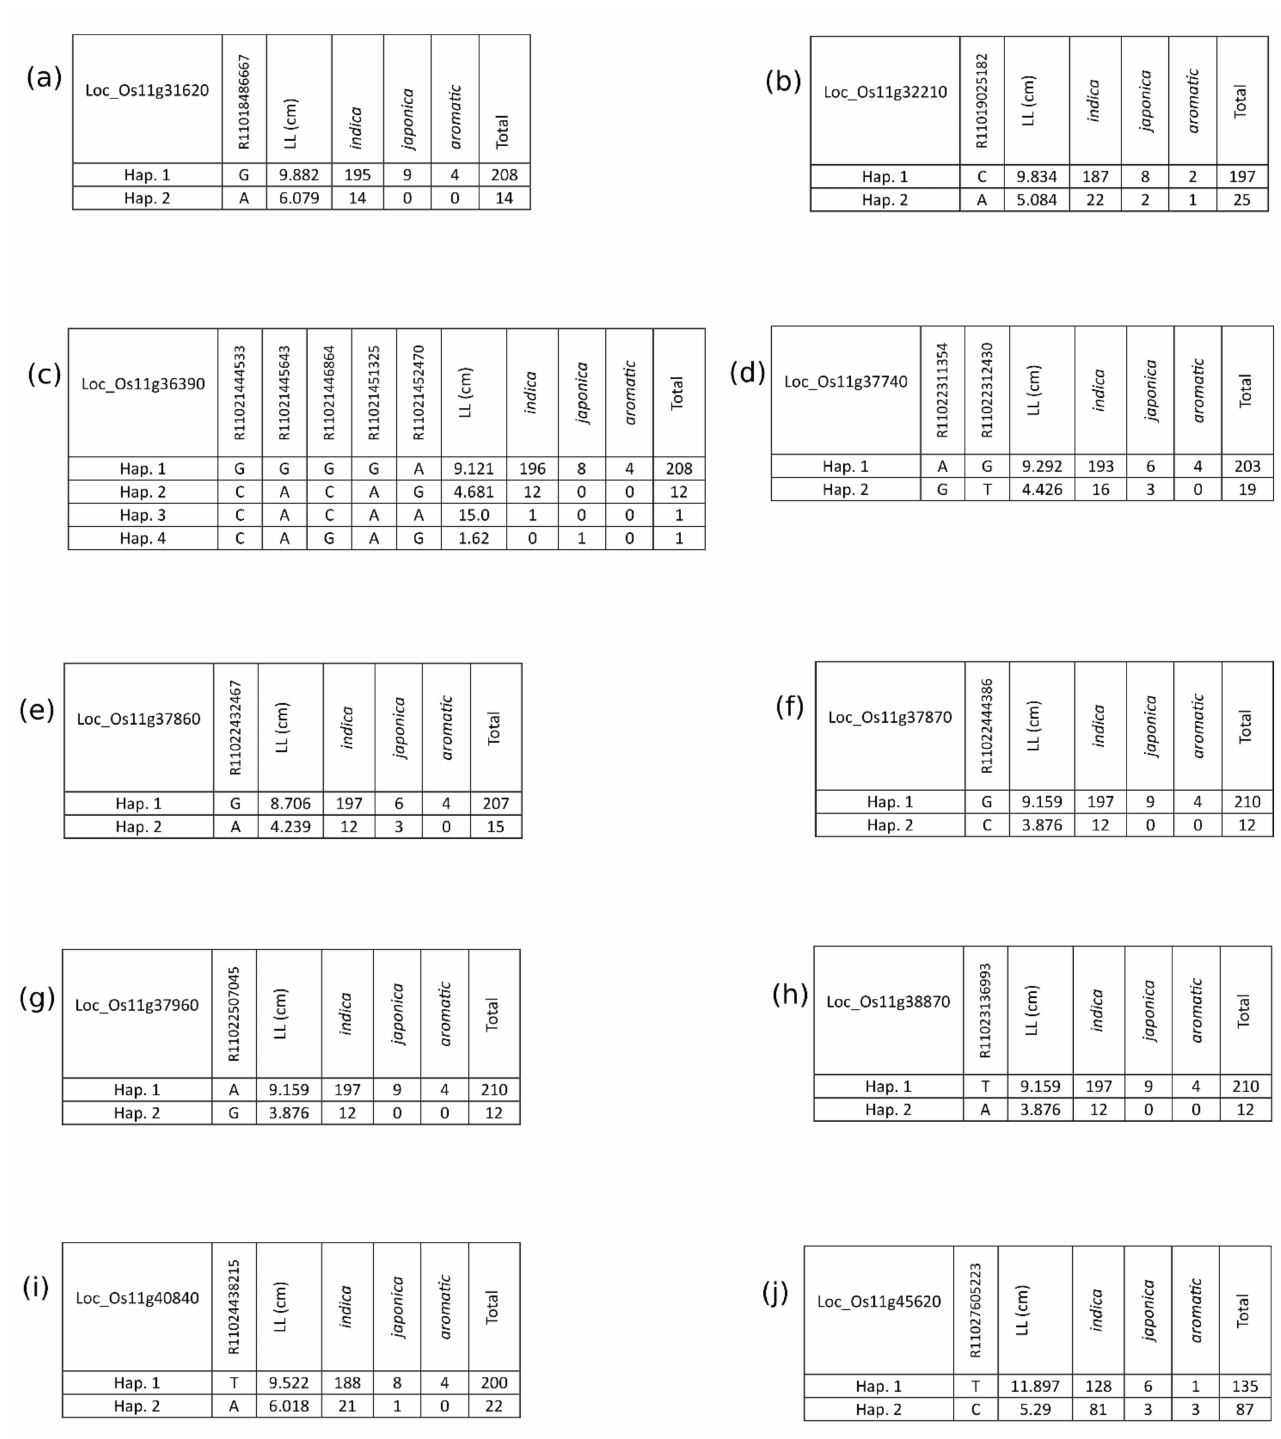
Figure 7. Tabular representation of alternative haplotypes determined by occurrence of significantly associated SNPs identified by GWAS analysis. ( a – j ) indicates specified MSU annotated